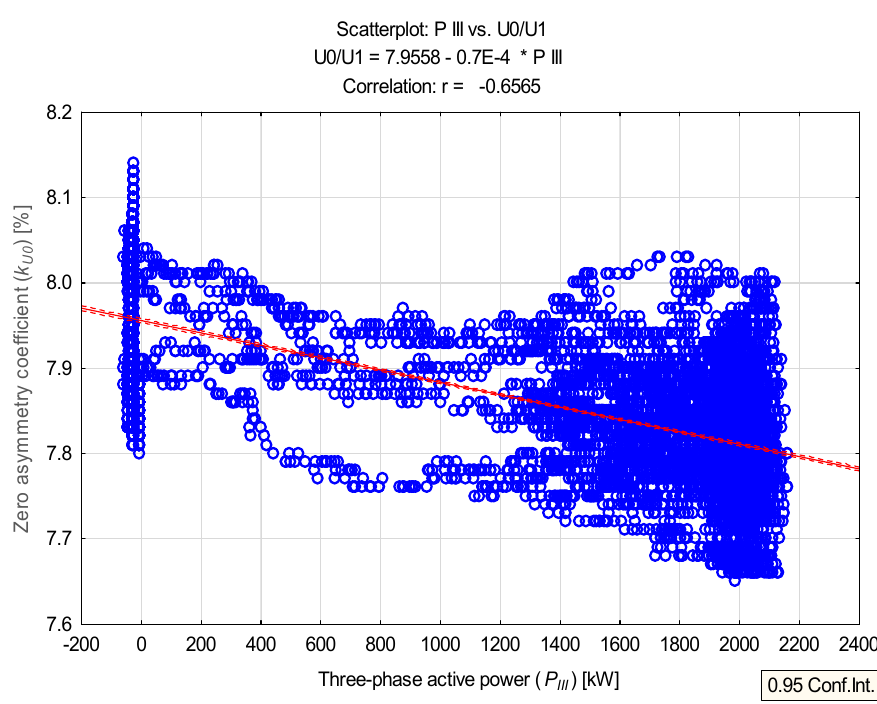
Figure 12. Diagram of the dependence of the value of the zero voltage asymmetry coefficient ( k U 0 ) at the connection point on the three-phase active power ( P III ) generated by the wind power plant.